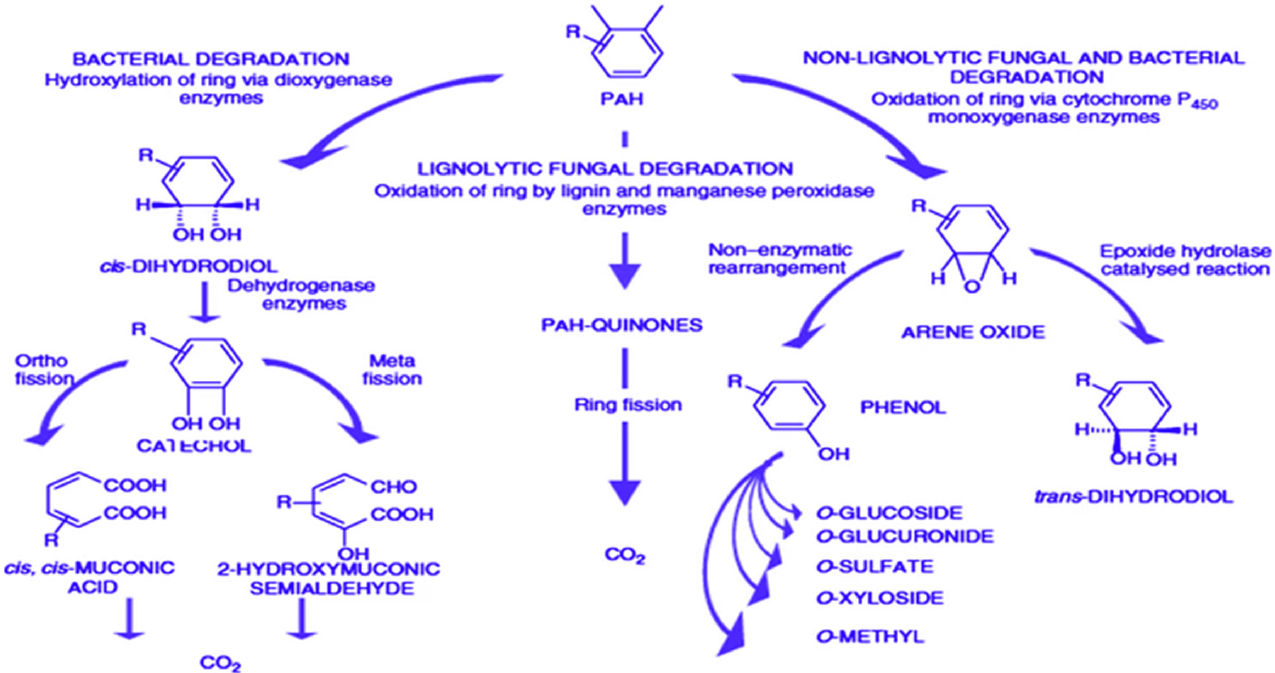
Figure 7. Three central PAH breakdown mechanisms by bacteria and fungus [96].